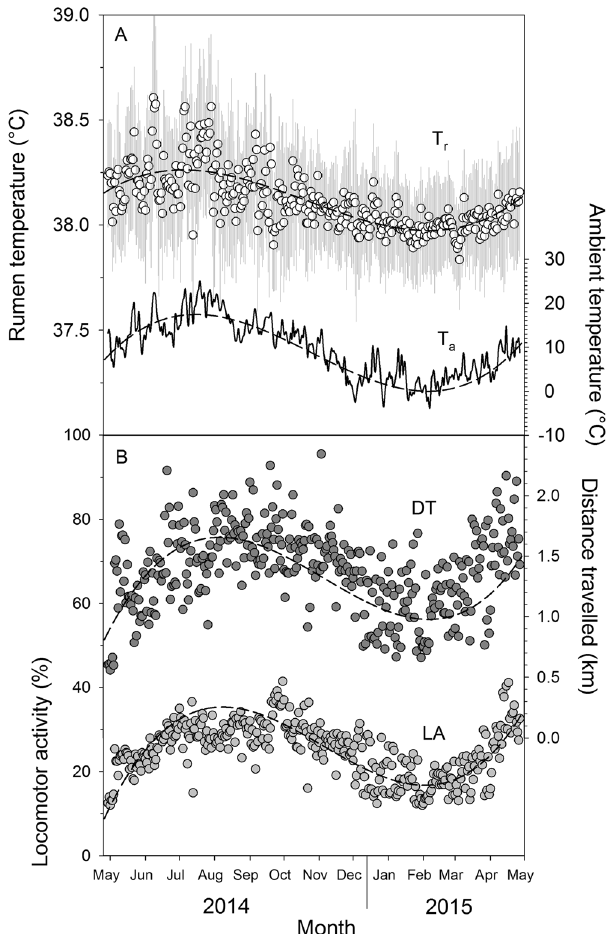
Figure 1. Yearly rhythm of rumen and ambient temperature as well as locomotor activity and distances travelled in llamas. Data are daily average rumen temperature (T r , white dots with average minima and maxima, N = 7) and daily average ambient temperature (T a , black solid line; A ) as well as daily average locomotor activity (LA, light grey dots) and distances travelled (DT, dark grey dots; B ) in adult non-pregnant llama dams during one year (29 April 2014–28 April 2015). Black dashed lines are best fit models for each parameter in A and B (see text for model equations). Values for T r , LA and DT are means of seven animals over a total of 2321 recording